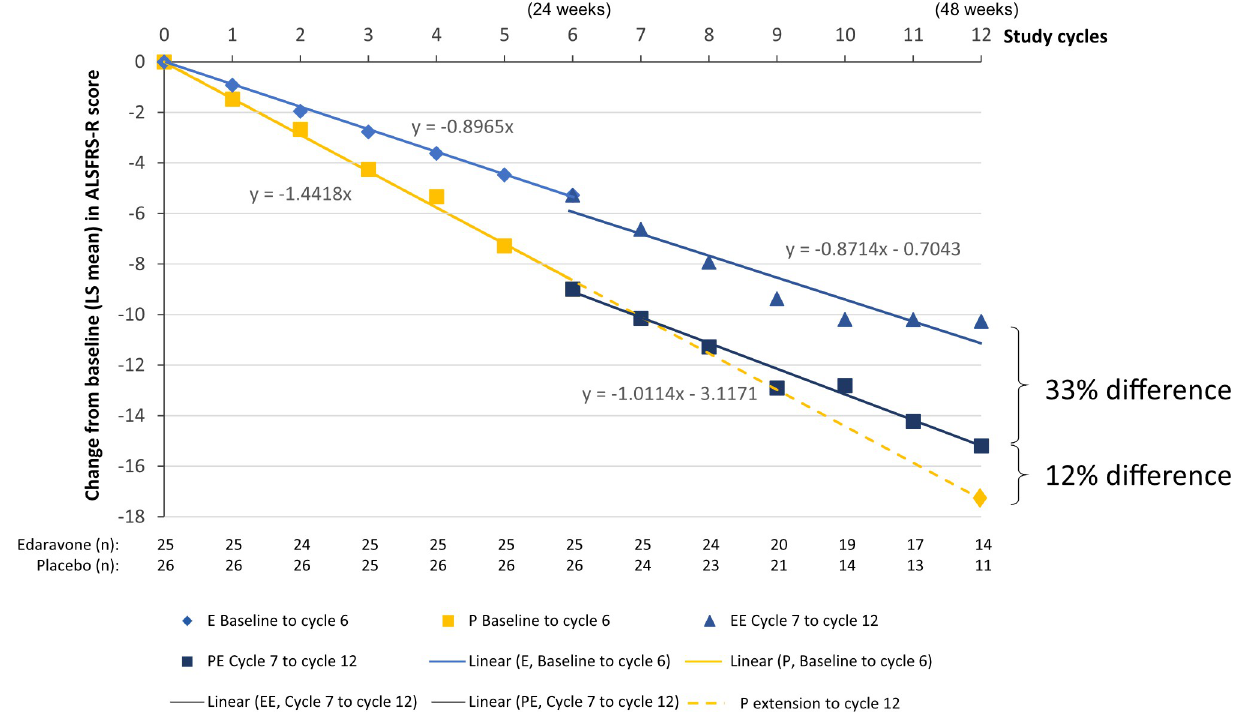
Fig 5. Regression analysis of change from baseline ALSFRS-R scores for the FVC 24 < 80%p subgroup. Symbols indicate treatment with edaravone (E, blue diamonds), placebo (P, yellow squares), edaravone-edaravone (EE, blue triangles), or placebo-edaravone (PE, blue squares). Data reflect LS mean change from baseline values. Linear regression line equations are shown on the graph. ALSFRS-R, Amyotrophic Lateral Sclerosis Functional Rating Scale-Revised; E, edaravone; FVC 24 , forced vital capacity at 24 weeks; LS, least squares; P,